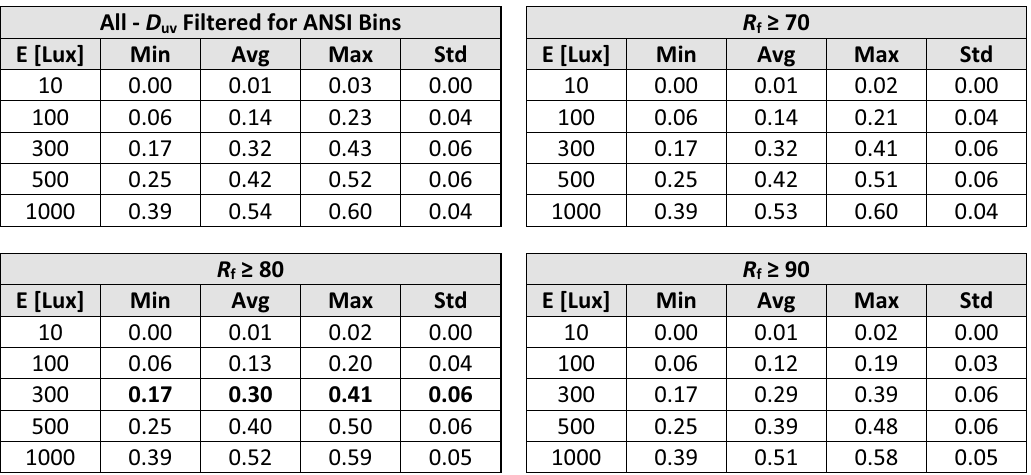
Figure 13 makes this point more forcefully, showing the relationship between CS and mel-EDI at a fixed illuminance of 500 lx with CCT sub-divisions. Visibly, no best-fit equation could satisfactorily describe this relationship. Even if tempted to build best-fit relationships for CCT subgroups, CS can vary between 0.26 and 0.45 for CCT = 3500 K, and from 0.28 to 0.35 for CCT = 4000 K, each at a fixed mel-EDI of 300 lx. Even if such a range is acceptable, or a simple relationship could be found, for example by inappropriate selective paring of the dataset or analyzing only broadband phosphor-converted LEDs, the conceptual and computational differences between measures like CS and measures like mel-EDI make such a conversion inappropriate. Figure 13 is useful for evaluating a recommendation of UL 24480 24 which states that without regard to spec- trum, a photopic illuminance of 500 lx can be specified to achieve the daytime recommendation of CS ≥ 0.3. They indicate that at 500 lx, “90% of commercially available LEDs with CCTs between 2700 and 6500 K will meet the circadian-effective light design criterion of CS ≥ 0.3.” In this analysis, 97% of SPDs at a photopic illuminance of 500 lx fall above the CS ≥ 0.3 criteria. Most of the SPDs with CS < 0.3, however, are at 3500 K and high color fidelity. This is a common lighting specification and is therefore potentially problematic. UL 24480 also makes recommendations of CS ≤ 0.2 and CS ≤ 0.1 in the evening and night, respectively. In this study, 99.5% of SPDs at 100 photopic lux had CS ≤ 0.2 (only 28.5% of SPDs had CS ≤ 0.2 at 200 photopic lux). Without regard to spectrum, a photopic illuminance of 100 lx can be reasonably assumed to comply with